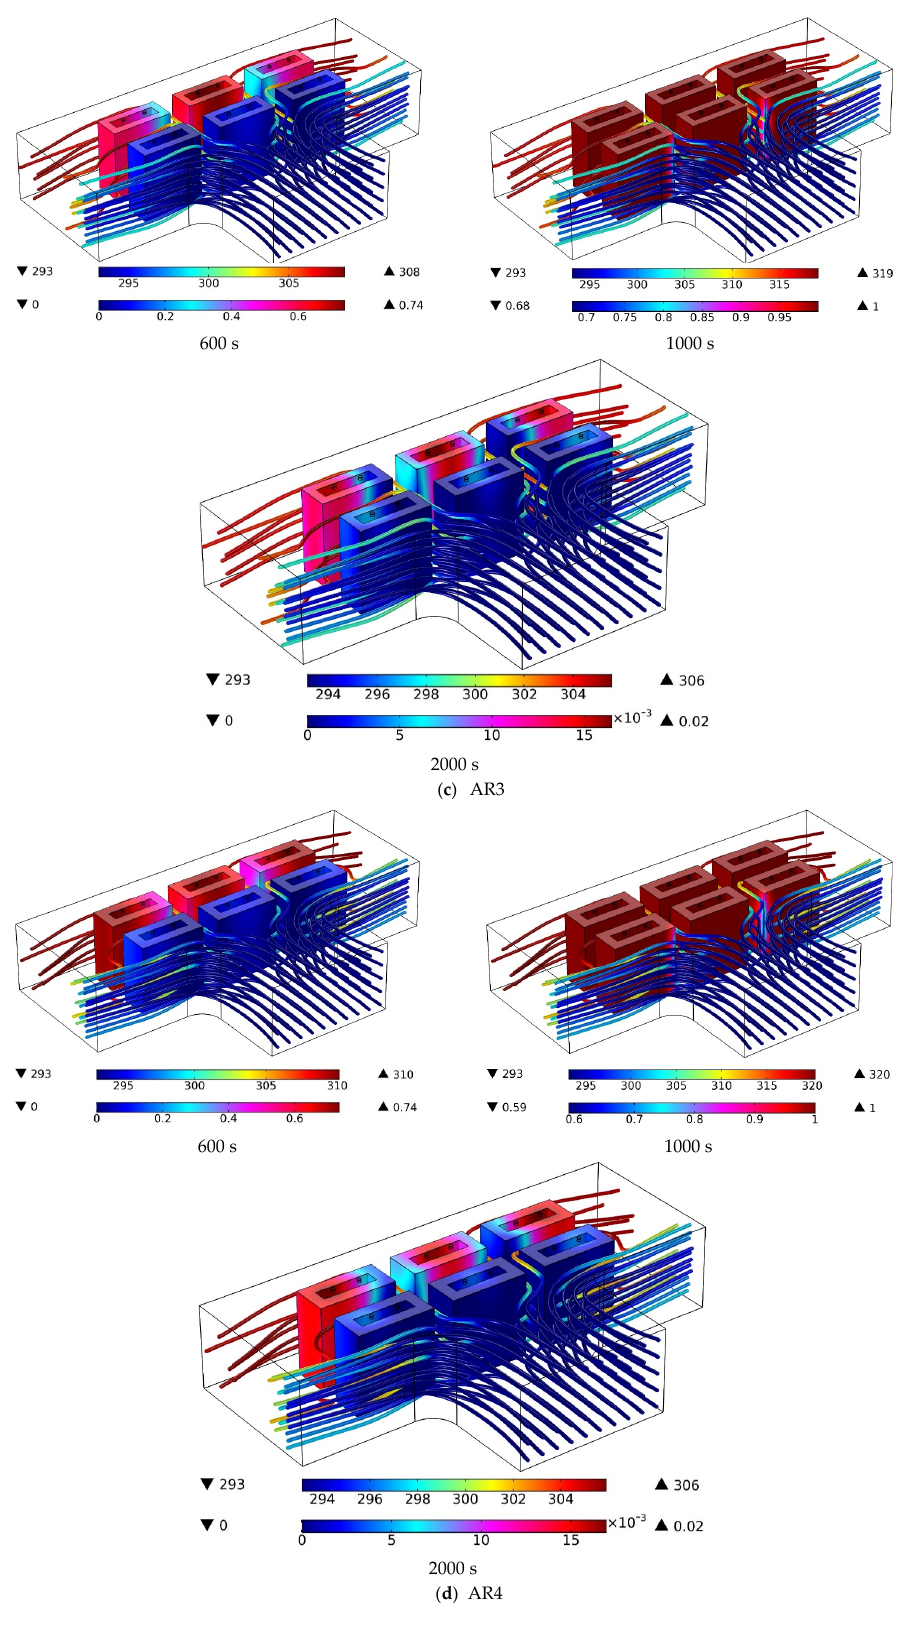
Figure 7. Temperature contours (in Kelvin) on the PCM cavity and air streamlines and velocity (in m/s) for different values of cavity AR.